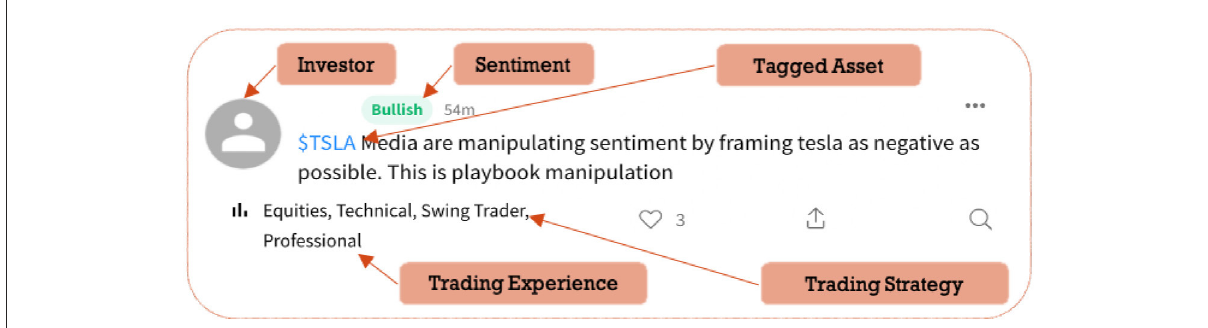
FIGURE1 An illustrative tweet posted by an investor with a detailed trading profile such as trading experience and trading strategy on StockTwits platform, clarifying also the tagged asset under discussion and the self-labeled investor